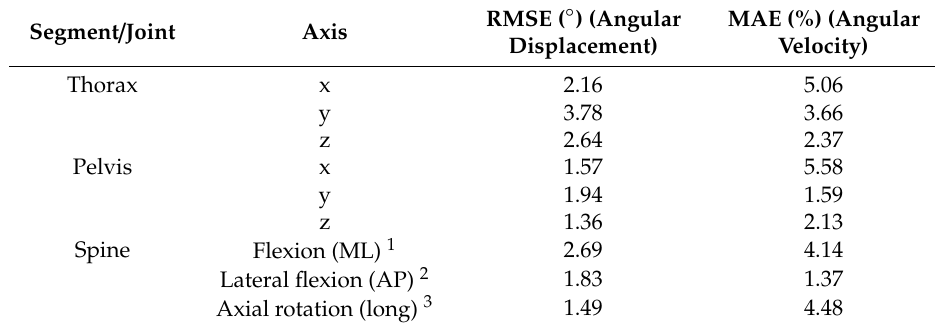
Table 1. Root mean square error (RMSE) in degrees and the mean absolute error (MAE) reported as a percentage of the peak values of the respective trunk kinematics.